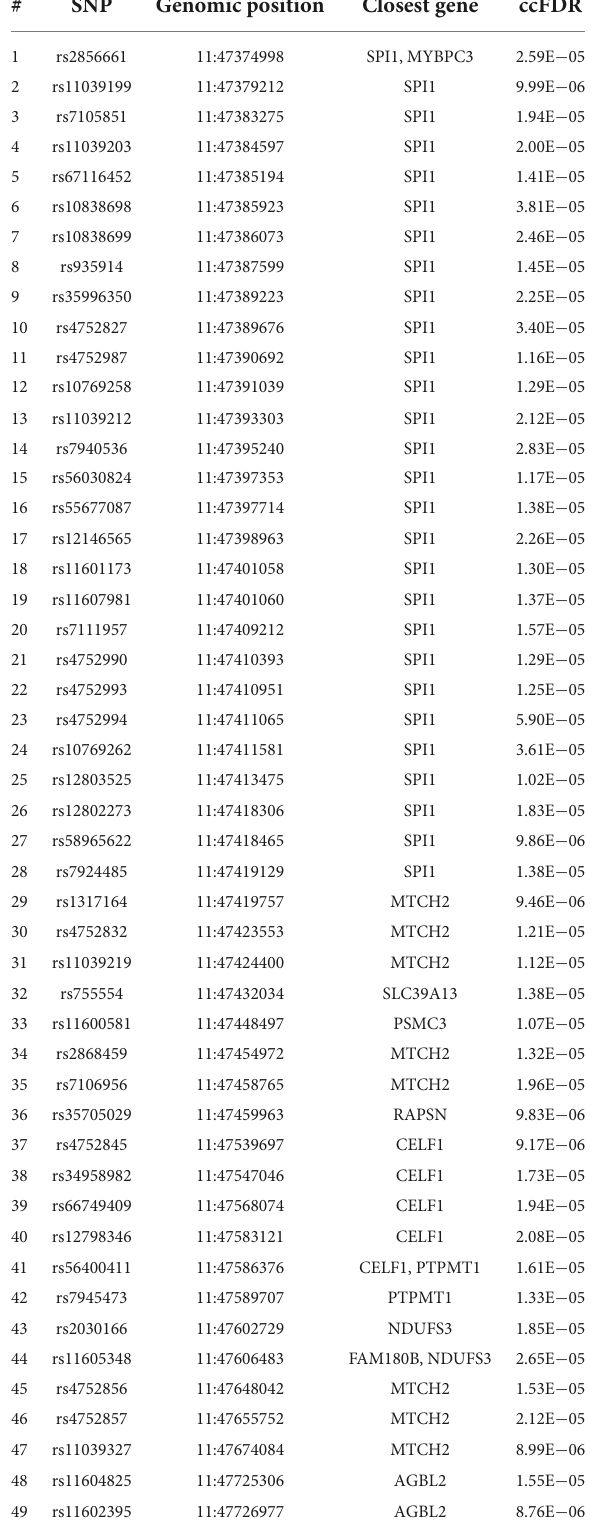
TABLE 1 Shared pleiotropic loci between AD and